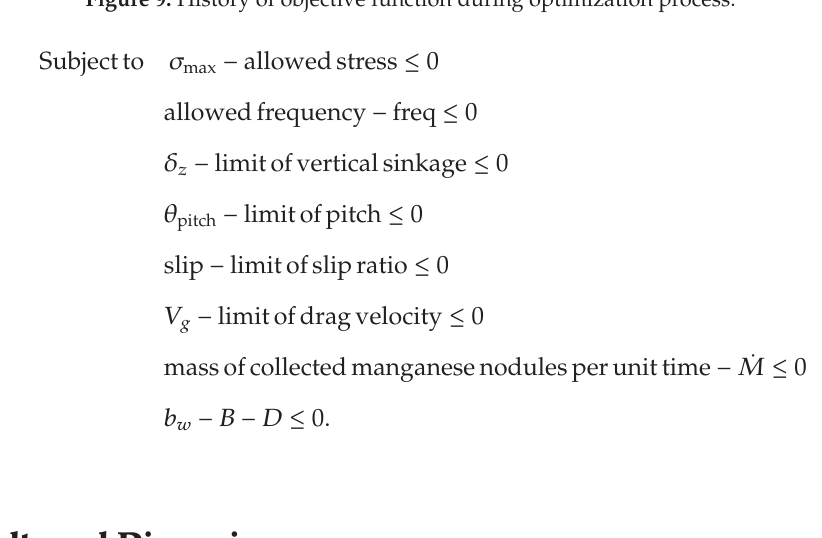
Figure 9: History of objective function during optimization